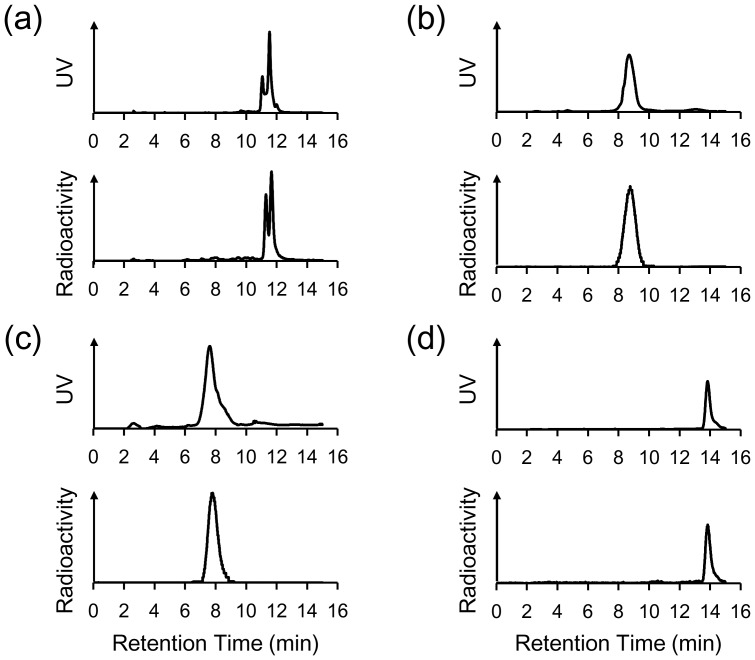
Reverse phase HPLC analysis after probe radiosynthesis.RI charts of (a) MDAP1000, (b) MDAP3000, (c) MDAP5000, and (d) MDAPCV are shown with UV charts of corresponding nonradioactive compounds.